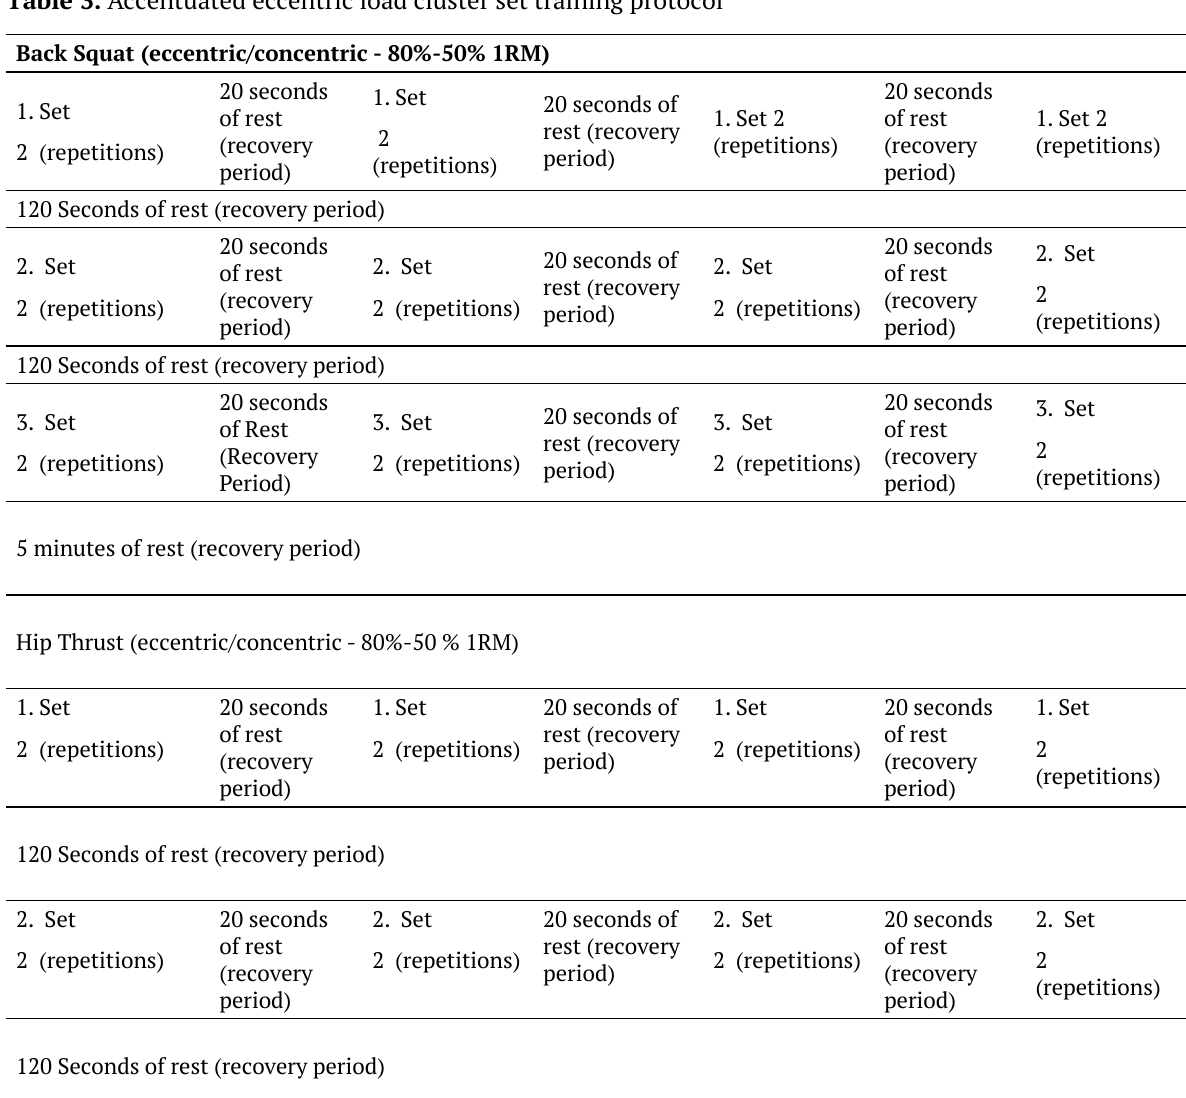
Table 3. Accentuated eccentric load cluster set training